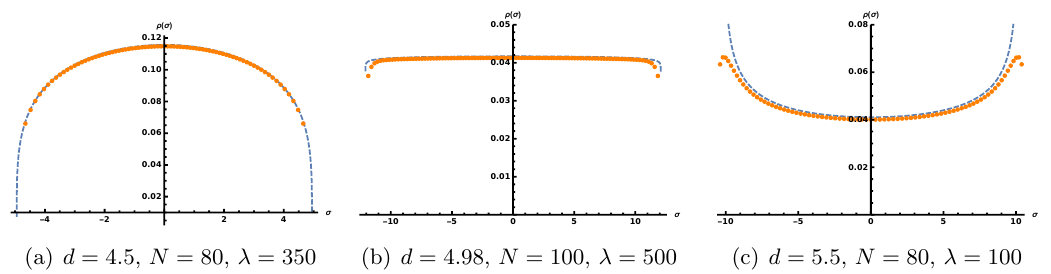
Figure 2 . The eigenvalue density obtained from the numerical solutions of the full saddle point equations (2.6) with various choices of parameters. The dashed lines represent the eigenvalue density in